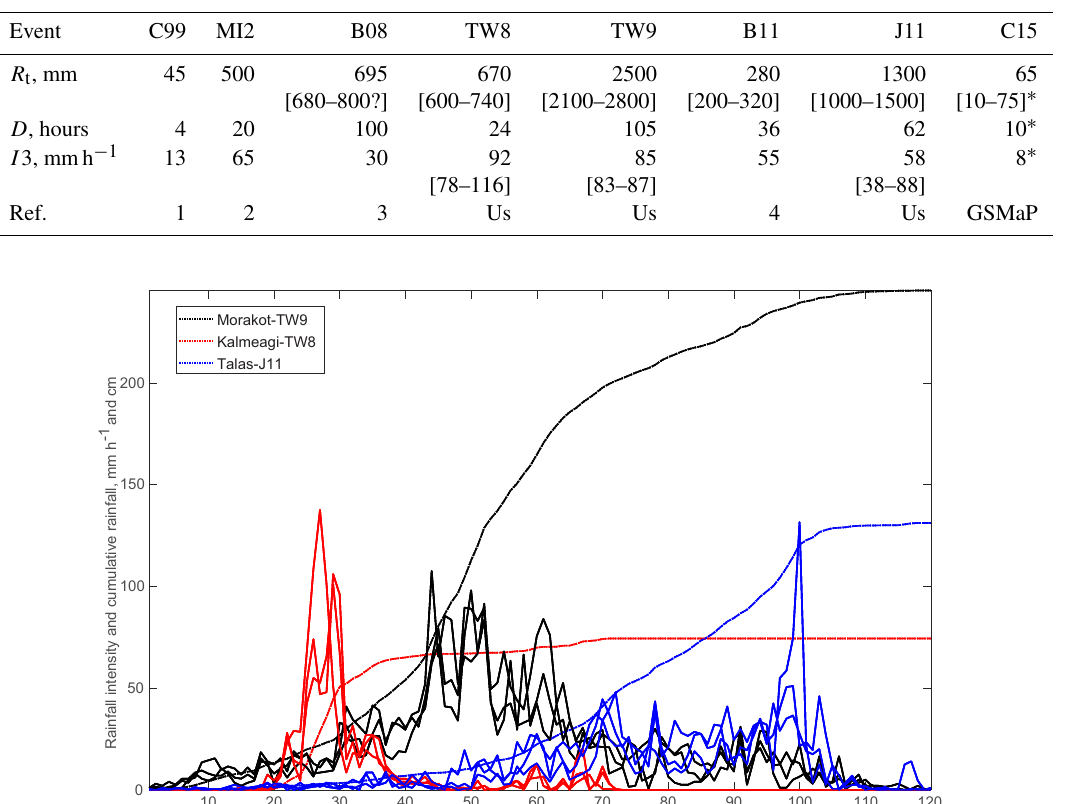
Figure 2. Rainfall history for typhoons Kalmaegi (TW8), Morakot (TW9), Talas (J11). For each event, hourly intensity is shown with solid curves for three gauges nearby the area with most intense landsliding (see Fig. 1 for locations). Dashed lines represent the mean cumulative rainfall from the three